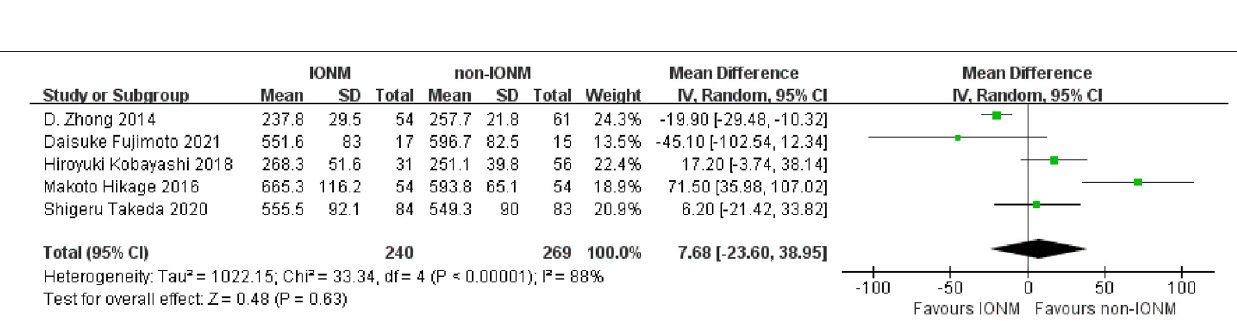
FIGURE 5 | Forest plot of operation time in the IONM and non-IONM groups.